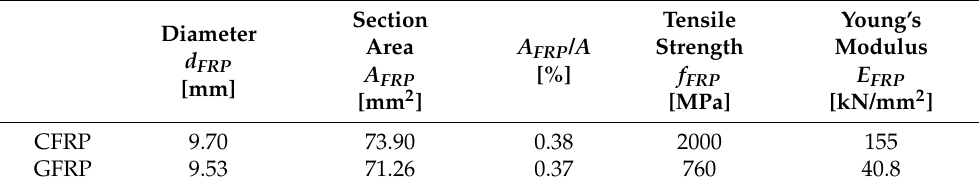
Table 1. Geometric and mechanical characteristics of FRP circular rods.